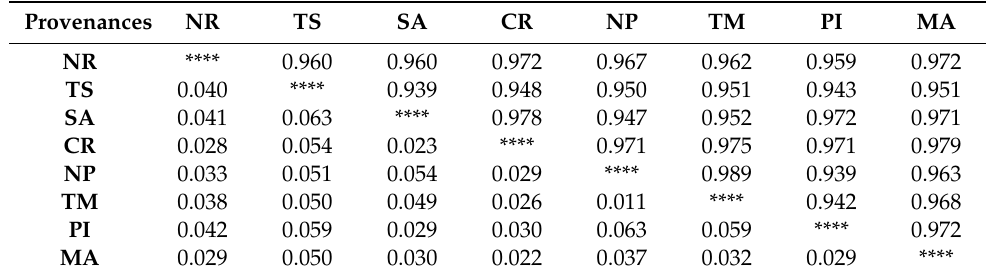
G. crinita provenances analysed by